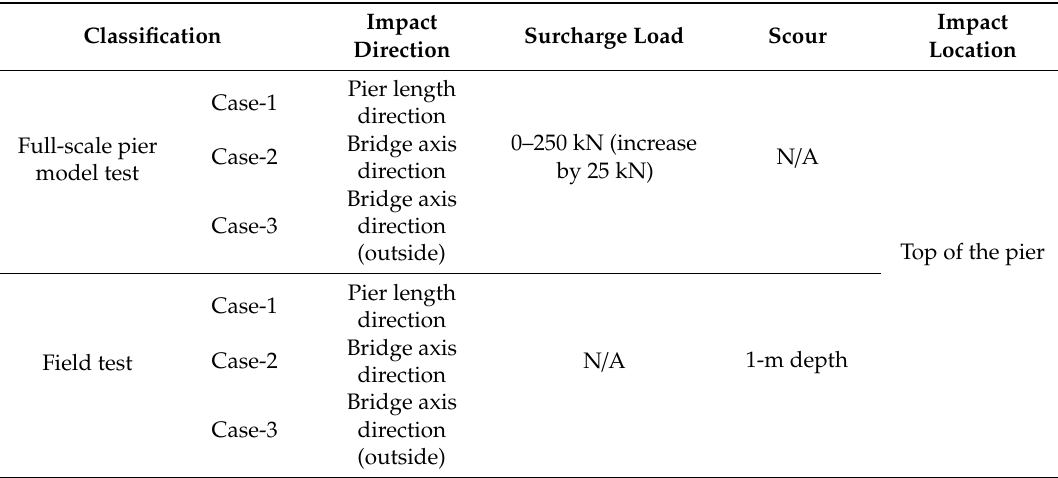
Figure 6. Conceptual diagram for the impact and measurement directions. Table 1. Test cases.